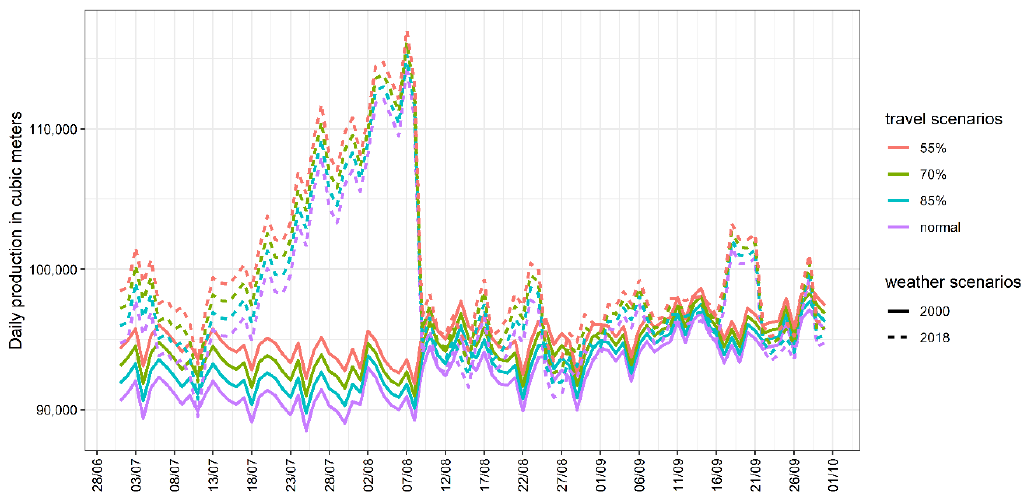
Figure 7. Predicted water demand for summer 2020 with different weather and travel scenarios.